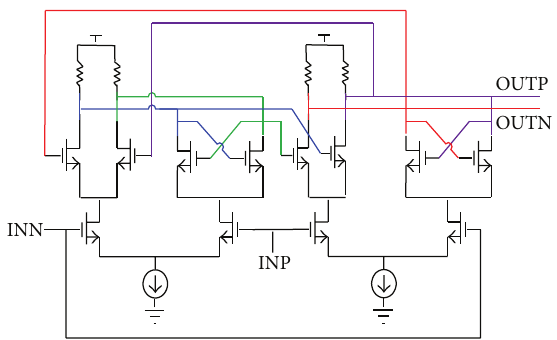
Figure 11: CML divider-by-2 schematic.